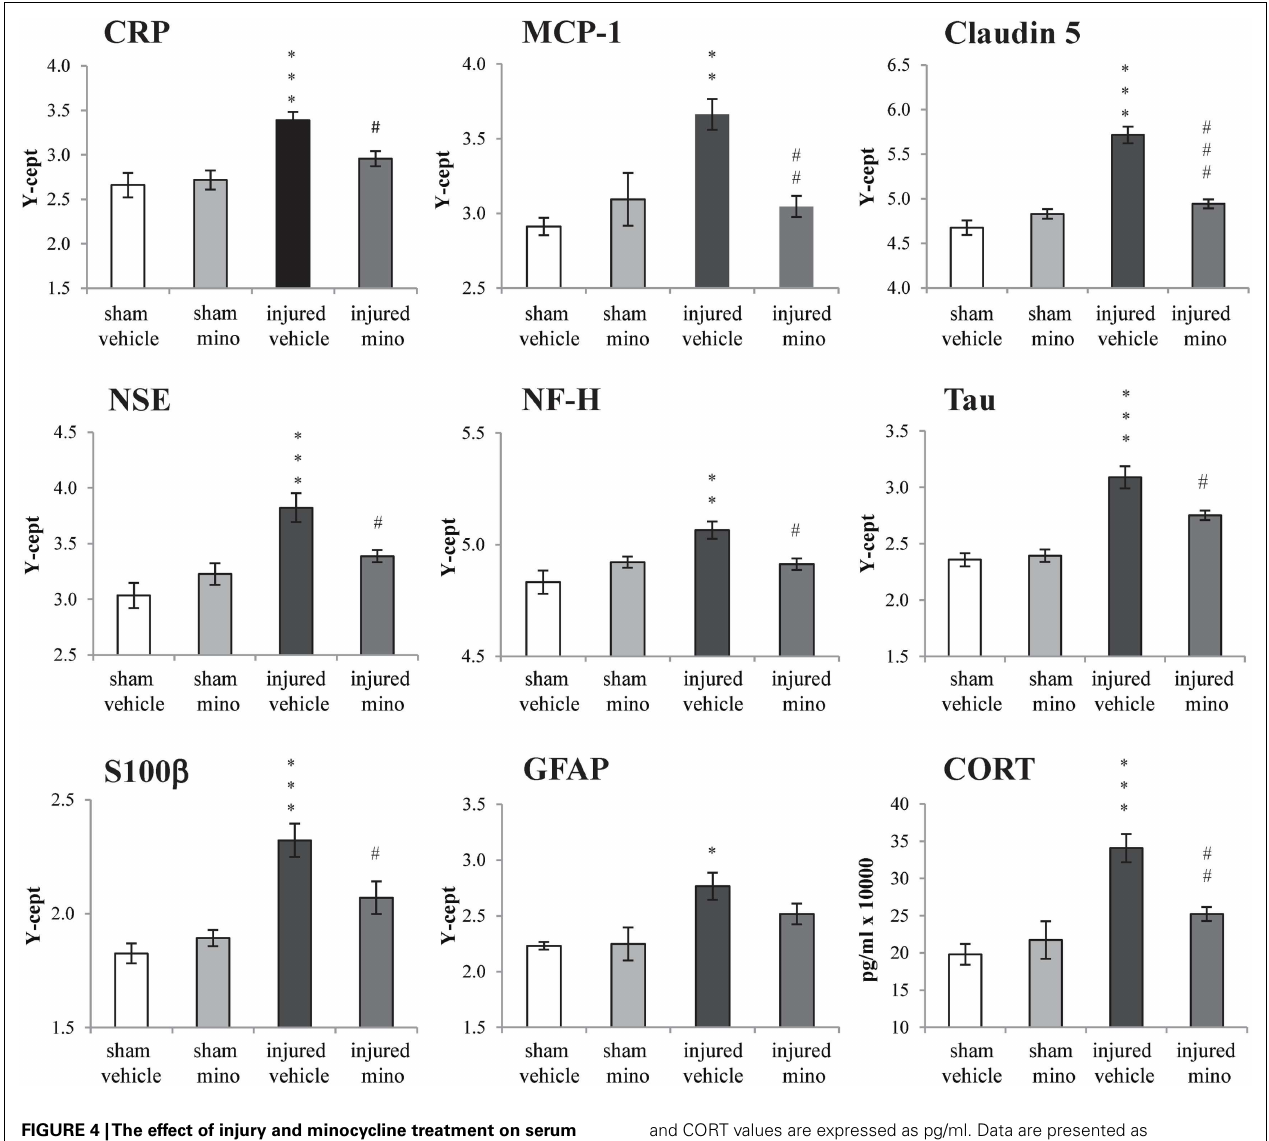
FIGURE 4 |The effect of injury and minocycline treatment on serum levels of selected markers in the different experimental groups. Serum levels of 8 protein markers were assayed by RPPM; CORT levels were assayed by ELISA. Protein values are expressed as y -axis intercept ( Y -cept)